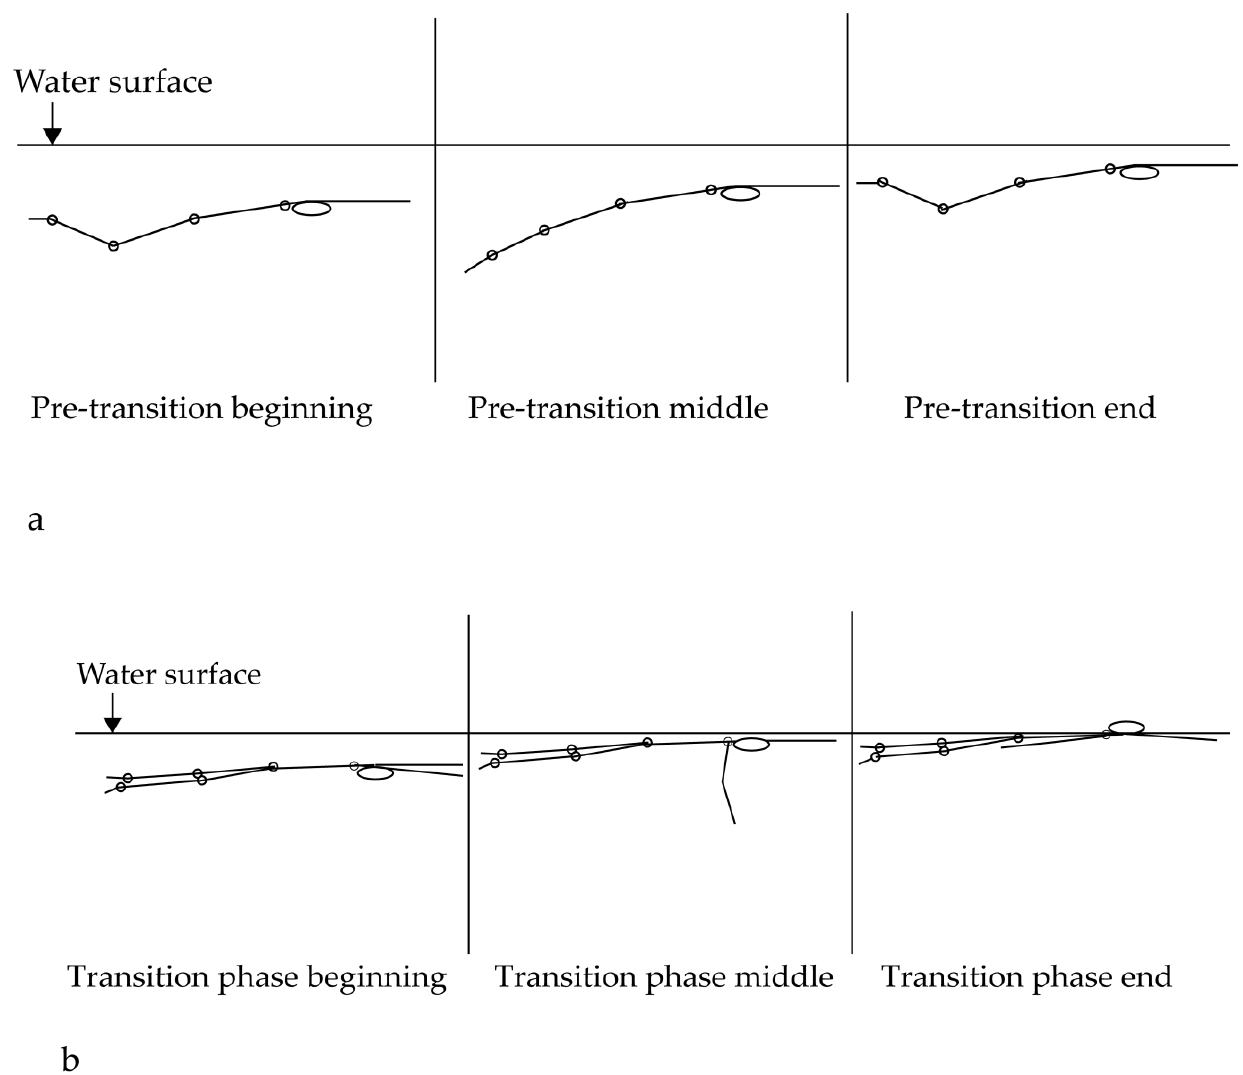
Figure 1. Schematic illustration of the pre-transition ( a ) and transition ( b ) phases from underwater to surface swimming.